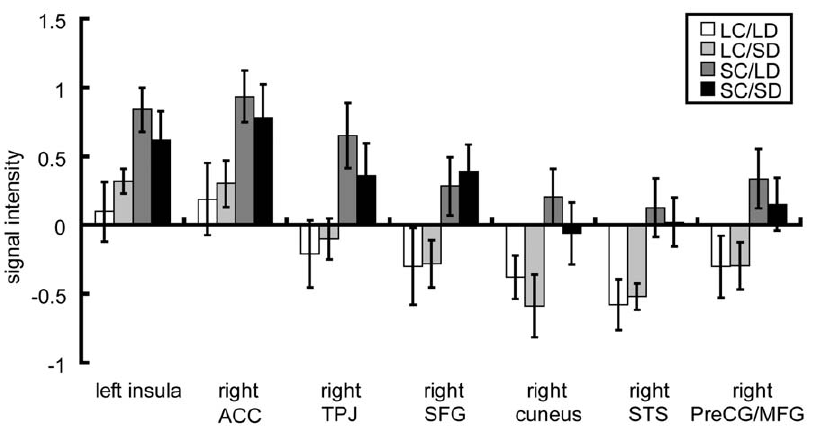
Figure 4. Average BOLD signal change from the rest in areas indicated in Figure 3b. Error bar indicates S.E.M. LC: the larger digit choice; SC: the smaller digit choice; LD: large-distance; SD: small-distance.